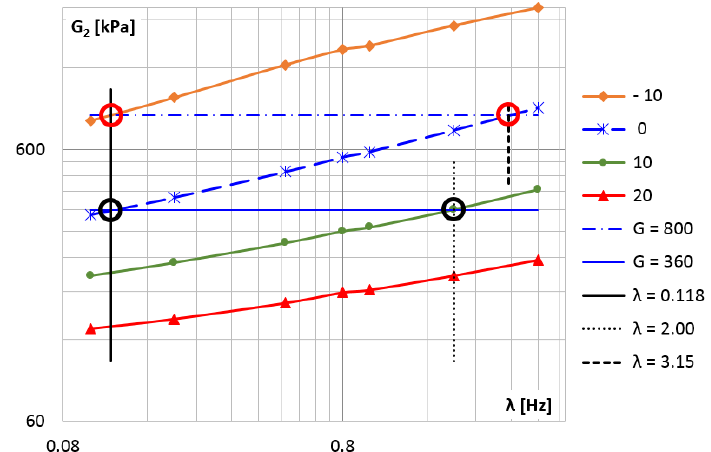
Figure 16. The loss modulus diagram for selected temperatures in the frequency domain. The determined constants C 1 = 18.08 and C 2 = 135.74 substituted into the Formula (44) lead to the shift factor α T as function of the relative temperature (cid:52) T i , the diagram of which is shown in Figure